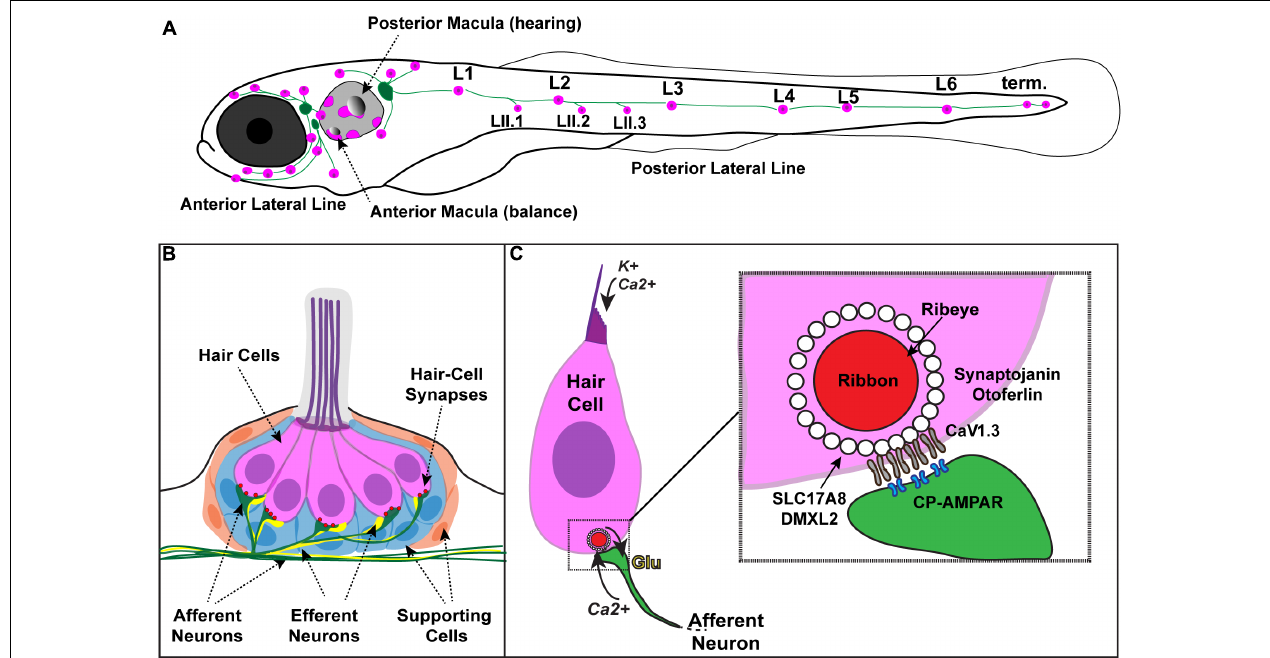
FIGURE 1 | Zebrafish hair cells and ribbons synapses. (A) Schematic depicts a larval zebrafish. Pink patches outline the location of hair cells in the inner ear required for hearing and balance, as well as hair cells in the lateral-line system. Green patches represent the location of the anterior and posterior lateral-line ganglia. The cell bodies of neurons in these ganglia project to and innervate hair cells in the lateral line. (B) An overview of the anatomy of a single patch of hair cells in the lateral line, referred to as a neuromast. Hair cells (pink) are surrounded by supporting cells (internal, blue and peripheral, orange) and innervated by both afferent (green) and efferent neurons (yellow). Mechanosensory hair bundles (purple) at the apex of hair cells project out into the water to detect local water flow. (C) Diagram of a single hair cell. Hair cells are activated when hair bundles are deflected, for example by local water flow. This apical deflection opens mechanosensitive channels allowing in cations including potassium and calcium. This apical activity depolarizes the hair cell, resulting in presynaptic calcium influx and release of glutamate onto the afferent neuron. Inset: magnified view of a hair-cell ribbon synapse. Shown are key evolutionarily conserved synaptic proteins discussed in this review. In hair cells, a presynaptic density called a ribbon (red) helps to recruit synaptic vesicles (white circles) to the synapse near clusters of calcium channels (Ca V 1.3). The ribbon is made up primarily of the protein Ribeye. Slc17A8 (Vglut3) and DMXL2 (Rbc3a) colocalize in or near synaptic vesicles. Synaptojanin and Otoferlin are also critical for ribbon-synapse function although their precise localization has not been definitively shown.